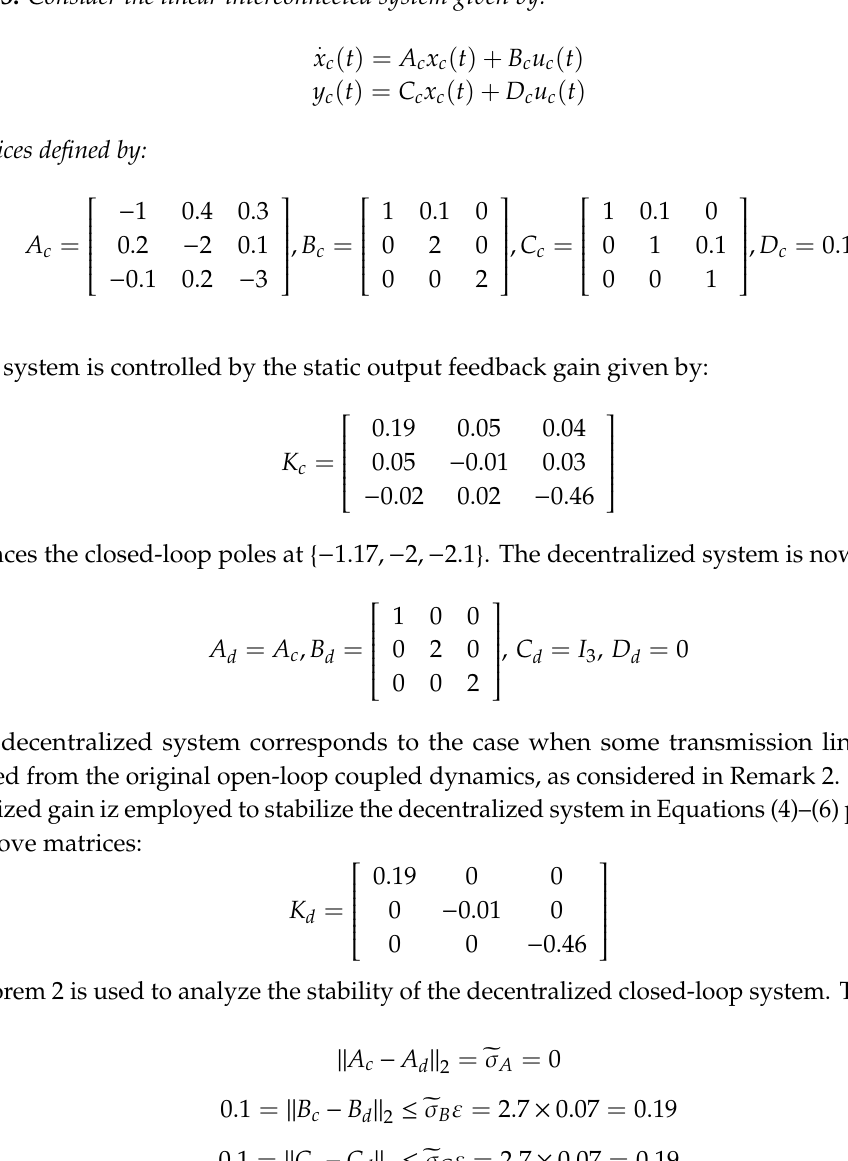
Figure 3. Evolution of the angles of both pendulums.